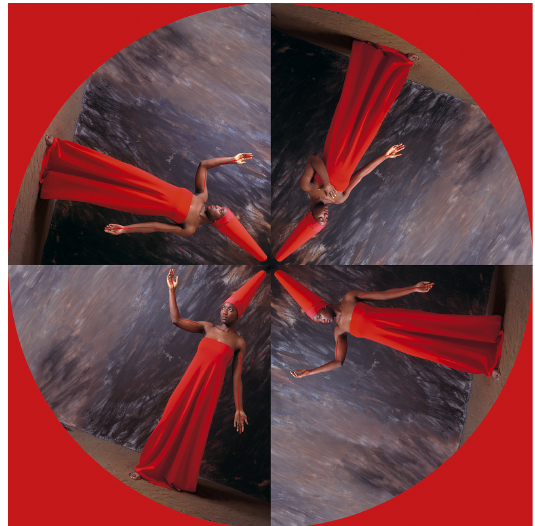
Figure 7. Maïmouna Guerresi, Mandala , 2006. Lambda print. 125 × 125 cm. © Maïmouna Guerresi, courtesy Mariane Ibrahim Gallery.